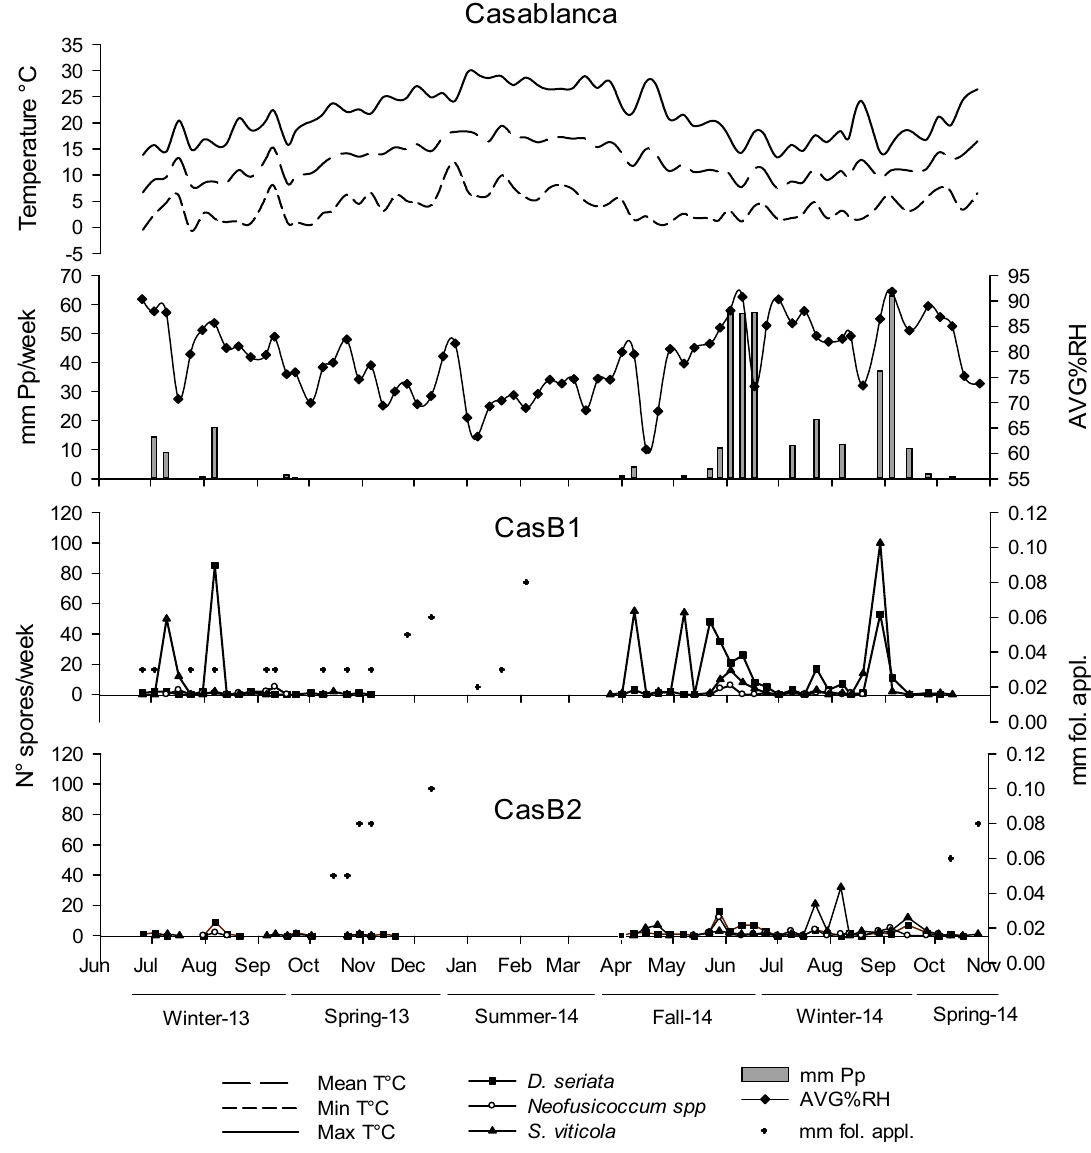
Figure 2. Weekly records of numbers of spore-trapped conidia of Diplodia seriata , Spencermartinsia viticola and Neofusicoccum sp. in two vineyards (CasB1, CasB2) in Casablanca, Valparaíso Region, Chile. Cardinal temperatures, relative humidity (diamond symbols) and accumulated precipitation (histogram bars) recorded during the experimental period are plotted at the top of the